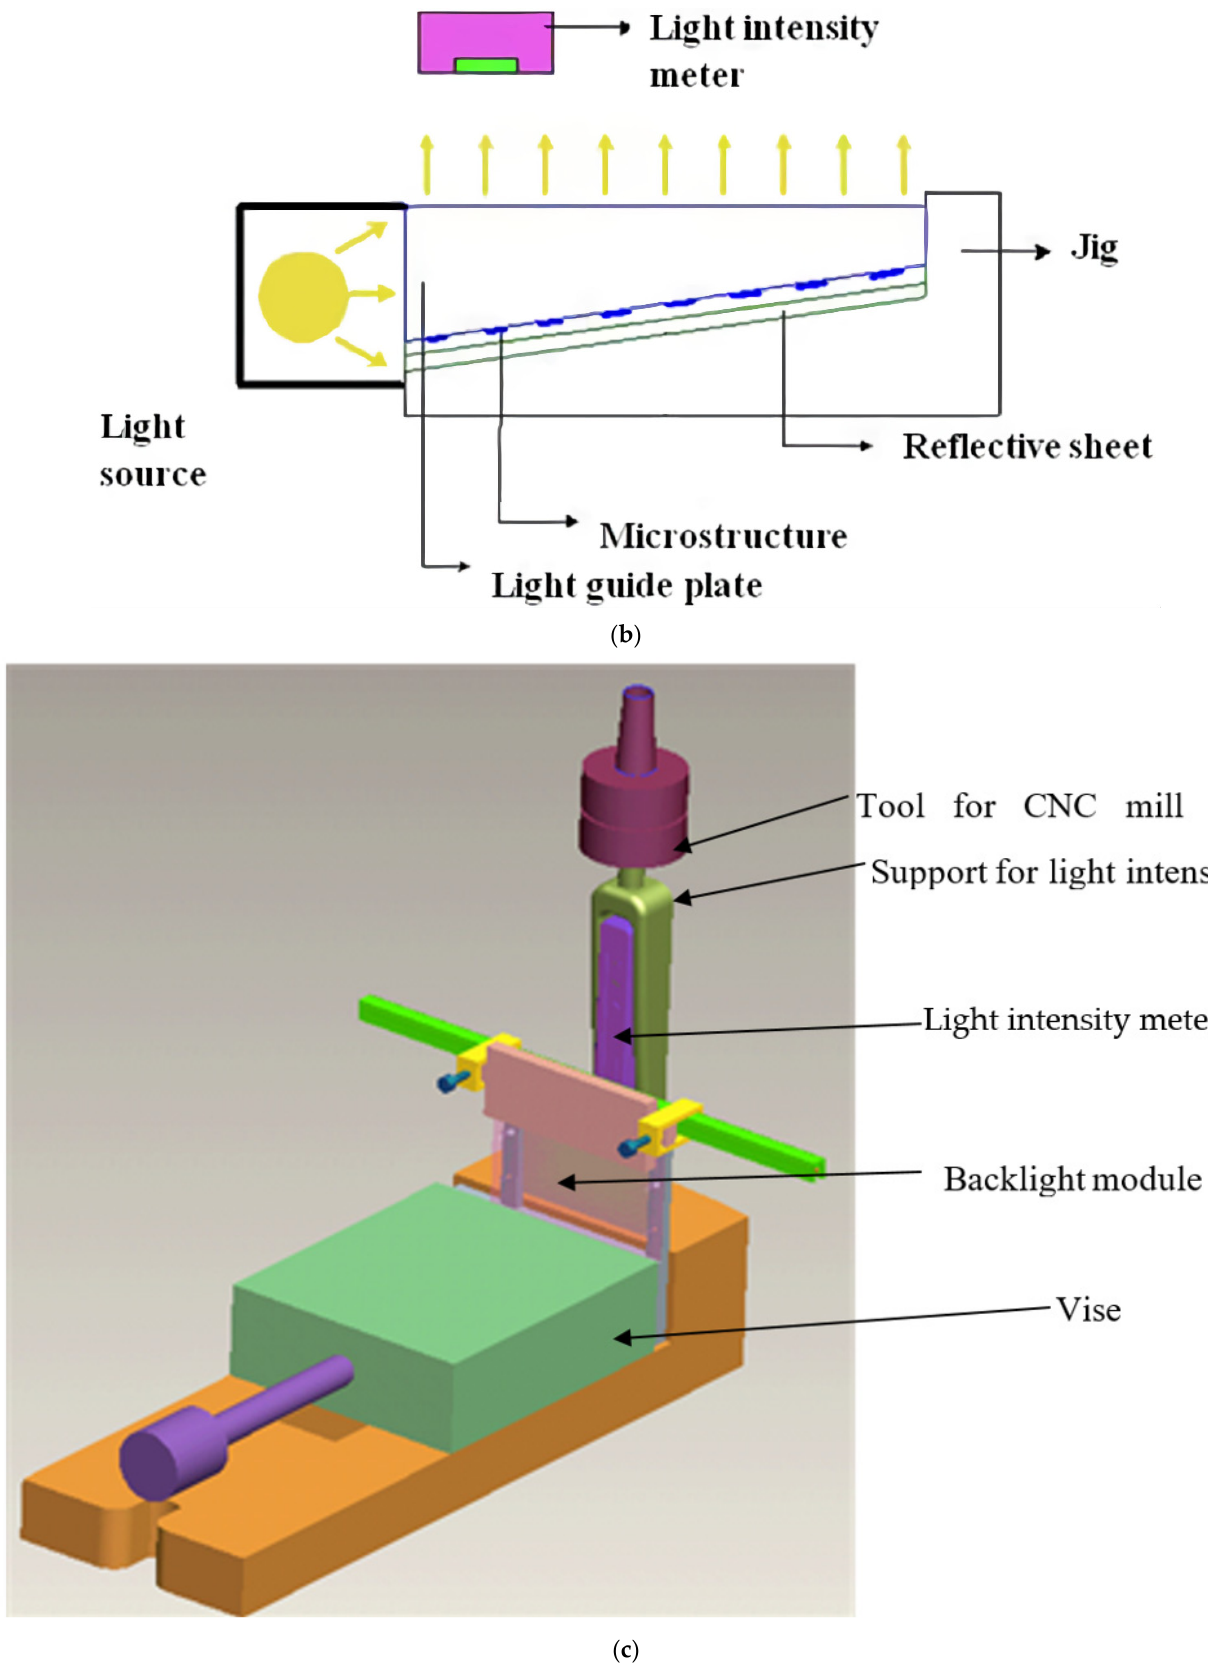
Figure 3. Measurement method of illuminance. ( a ) 3D illustrate; ( b ) 2D Illustrate; ( c ) Real situation for measurement .